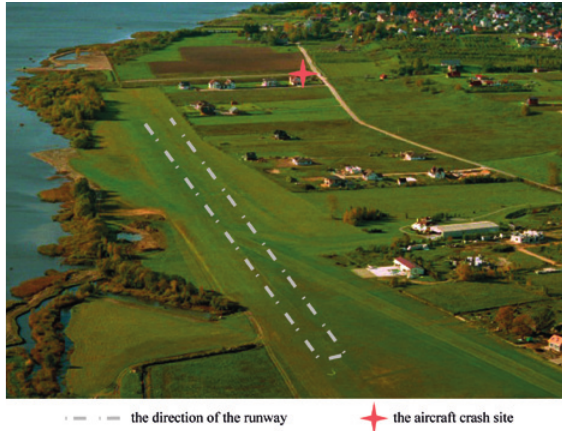
Fig. 1. The relative position of the runway and the aircraft crash